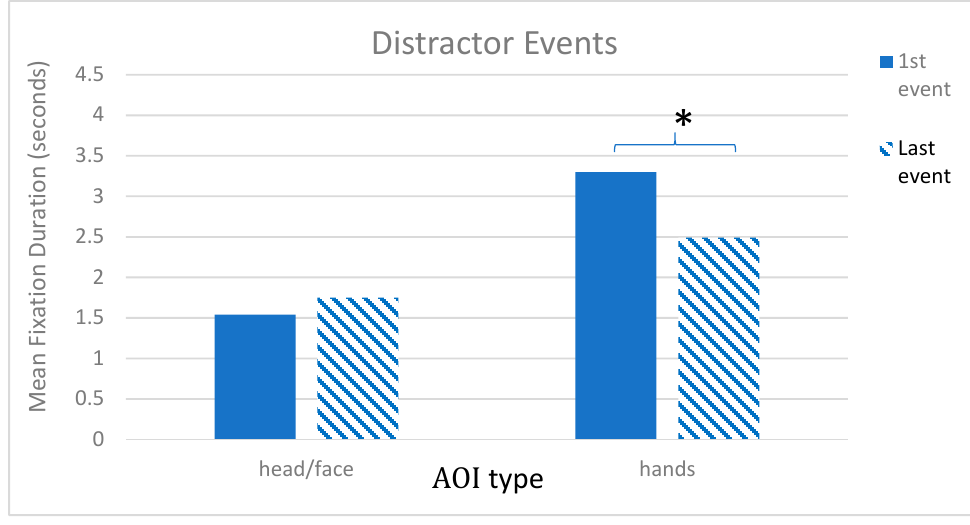
Figure 5. Distractor Events. Graph shows mean total fixation duration by Trial (first, last) and AOI type (head/face, hands), * p < 0.05.